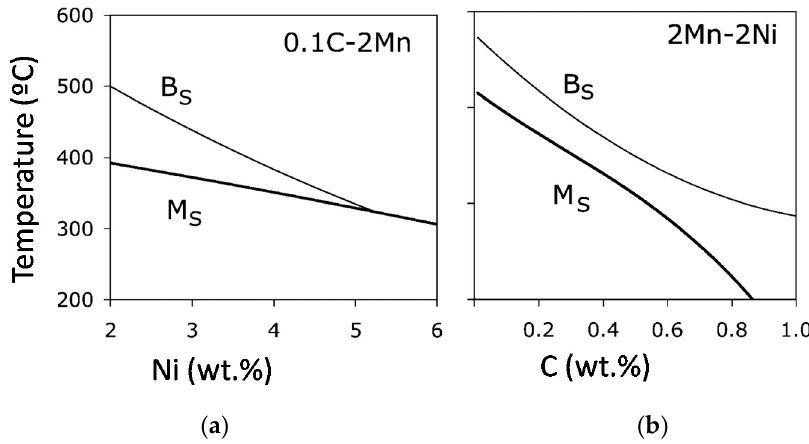
Figure 1 . Thermodynamics calculation of bainite and martensite start transformation temperatures: ( a ) effect of Ni in Fe-0.1C-2Mn (wt. %) alloy system; ( b ) effect of C in Fe-2Mn-2Ni (wt. %) alloy system. Adapted from [11].